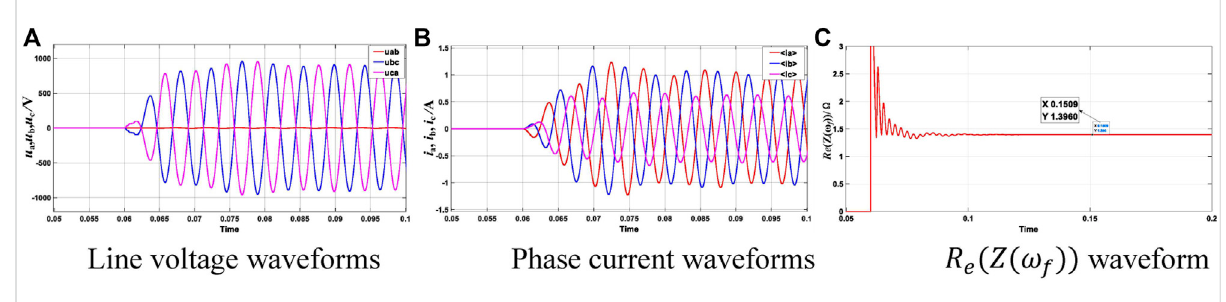
FIGURE 12 Permanent short circuit fault at end of Line3.